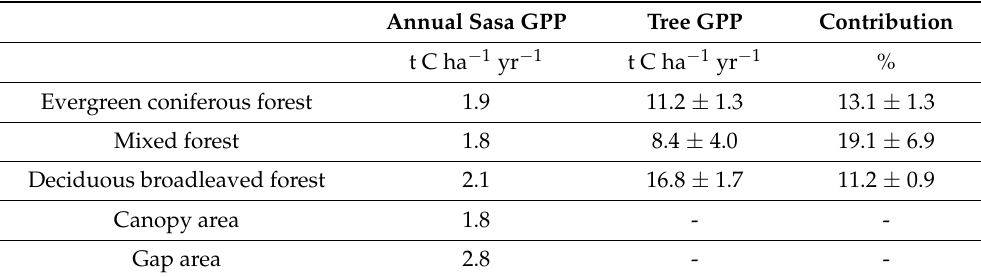
Table 5. Annual Sasa GPP and tree GPP at the forest ecosystem scale in the four sites and contribution of the Sasa GPP to the forest ecosystem